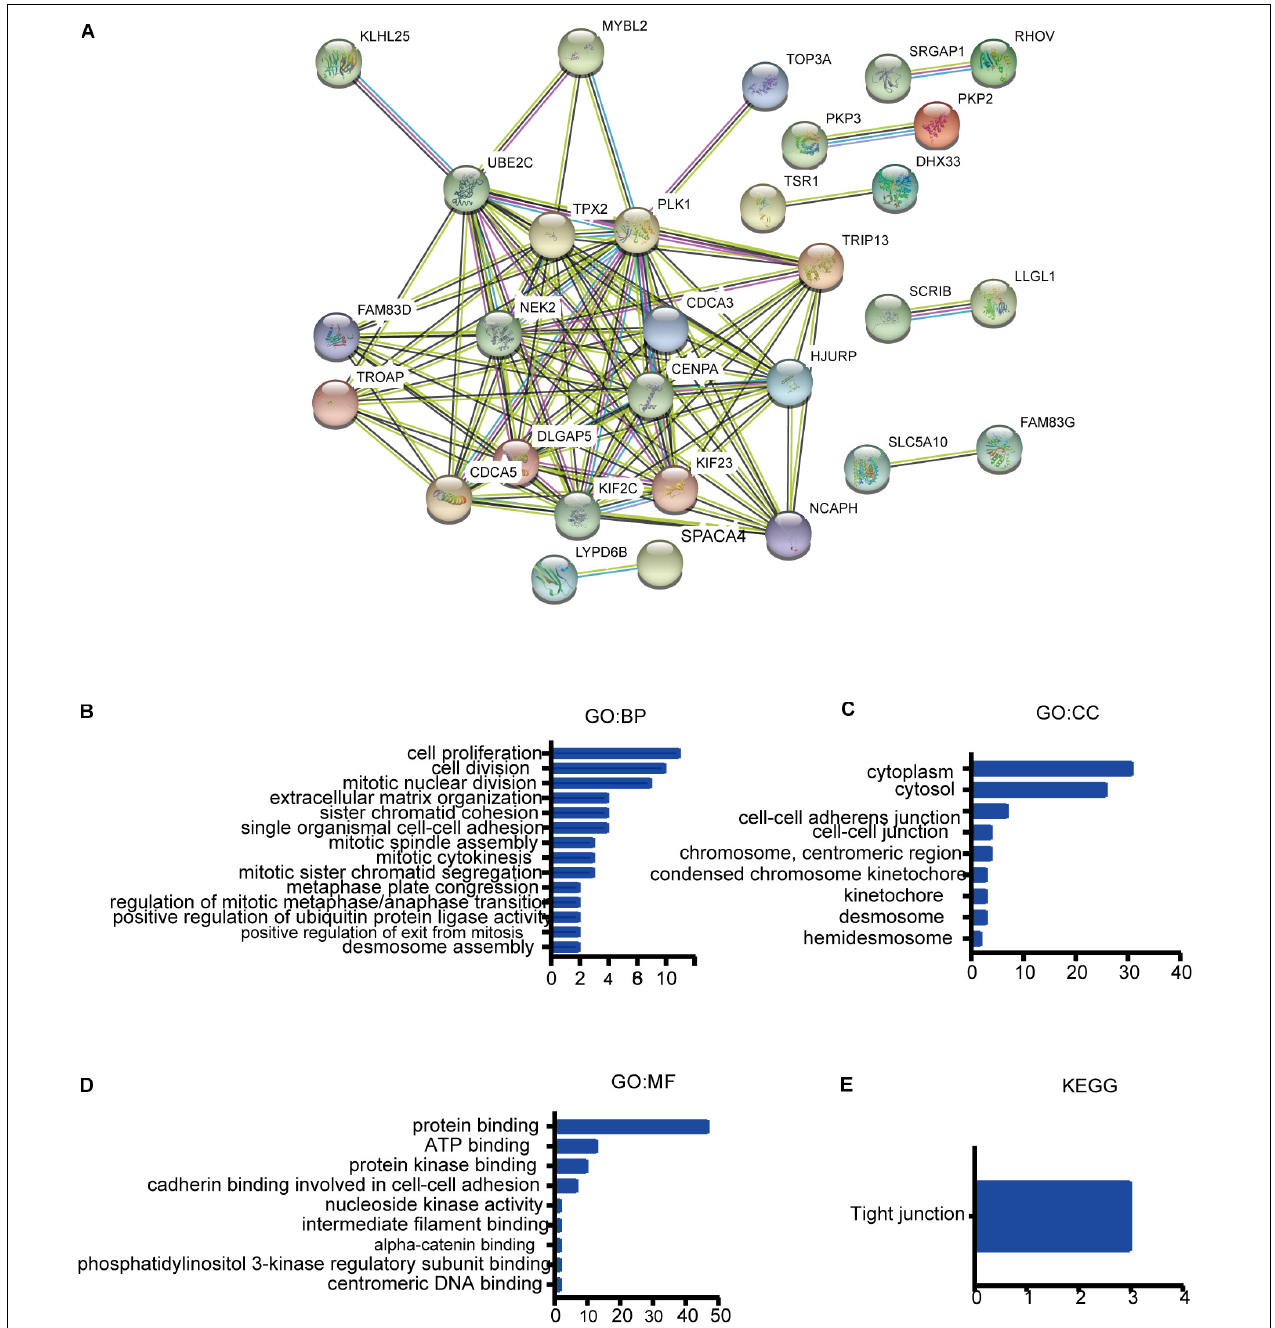
FIGURE 7 | GO and KEGG enrichment analysis of FAM83 family and their 80 co-expression genes in NSCLC patients. (STRING and DAVID). (A) PPI network. The nodes meant proteins; the edges meant the interaction of proteins (B) BP. (C) CC. (D) MF. (E)